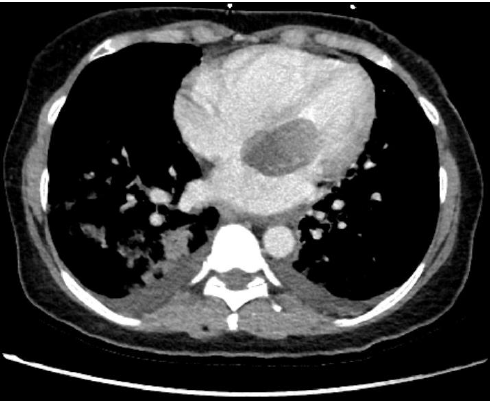
Figure 2. Visualization of a left atrial CM in a computed tomography scan with contrast medium. Cancers 2022 , 14 , x